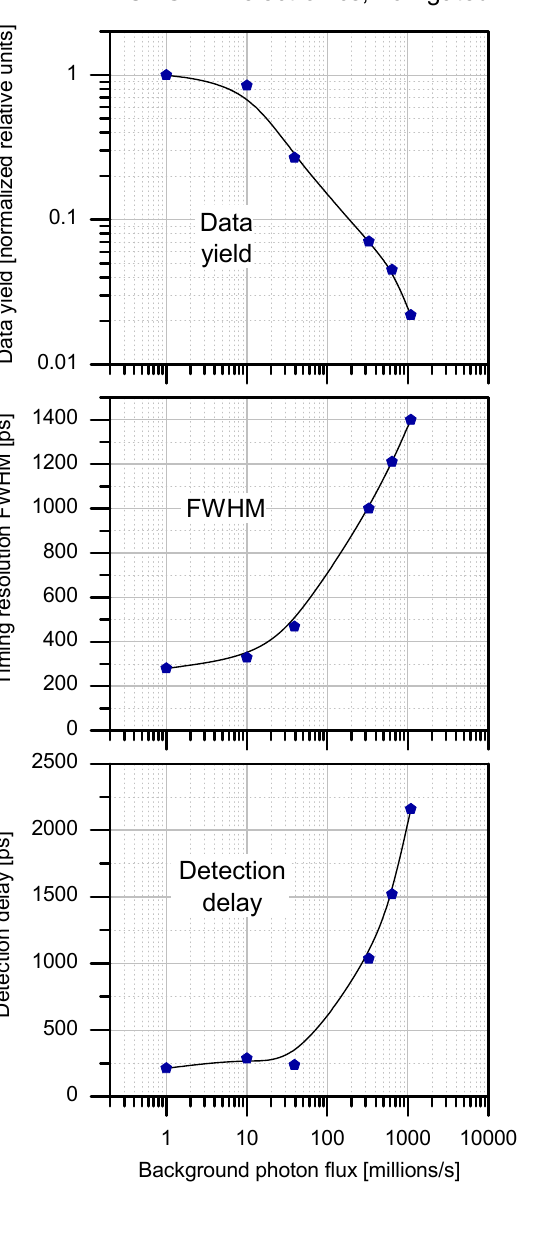
Figure 16. Comparison of gated and non-gated mode [10] of operation used in Laser Time Transfer (LTT)